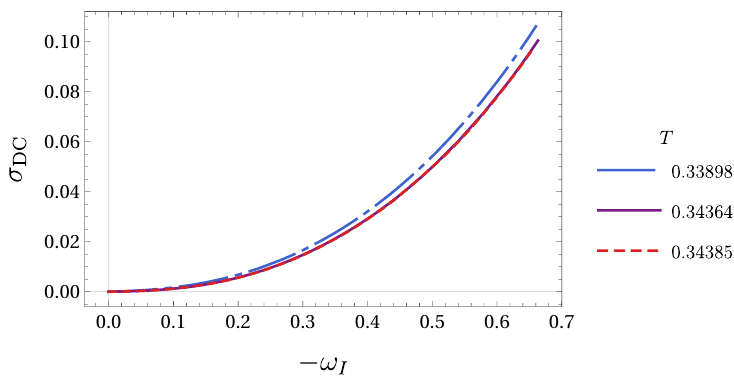
Figure 4 . DC conductivity σ DC vs. decay width − ω I at various temperatures. The lower two lines are almost